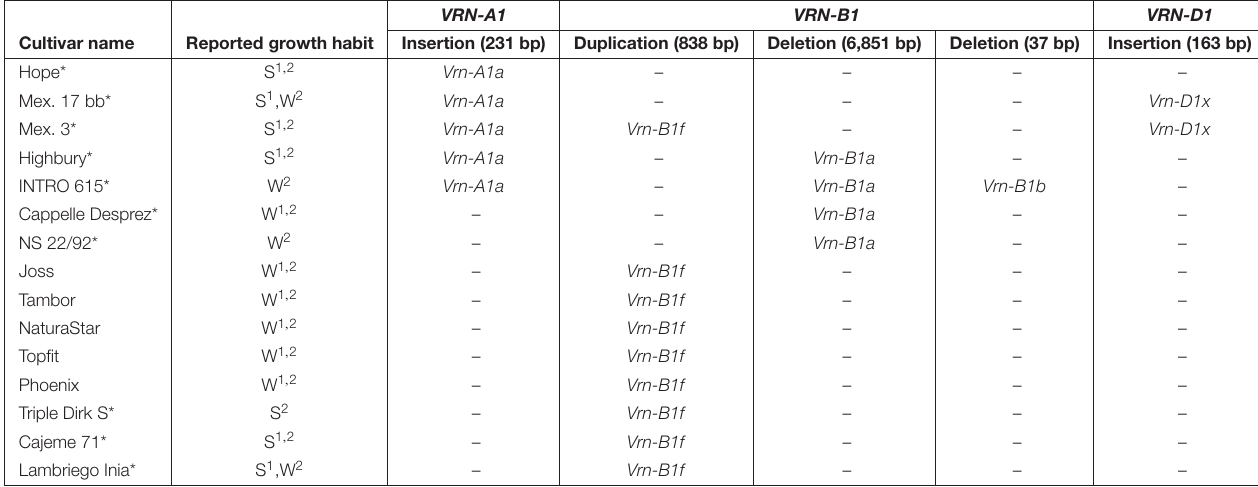
TABLE 2 | Cultivars with structural variations larger than 30 bp at three VRN1